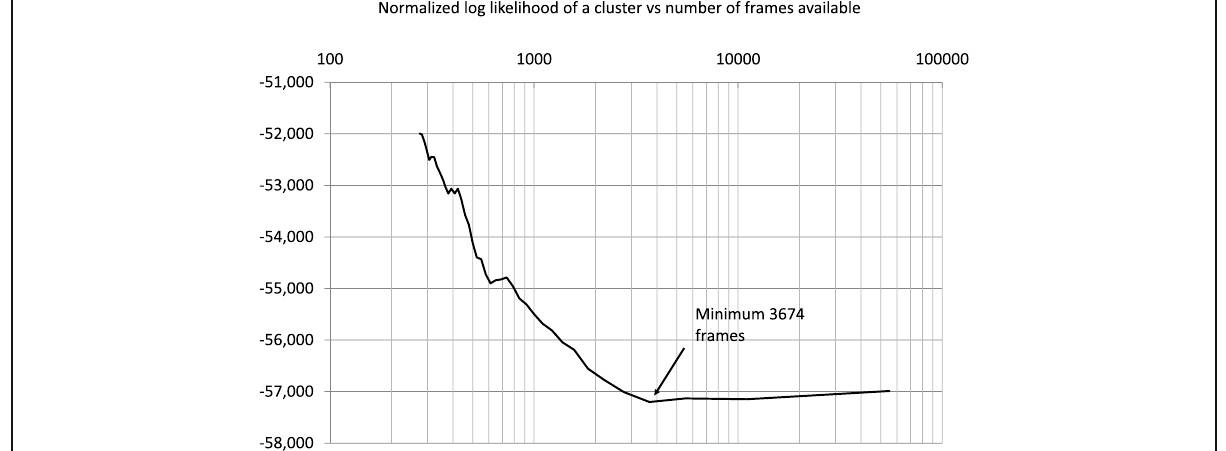
Fig. 9 Normalized log-likelihood of a cluster trained with 5 Gaussians as a function of the number of frames used to train